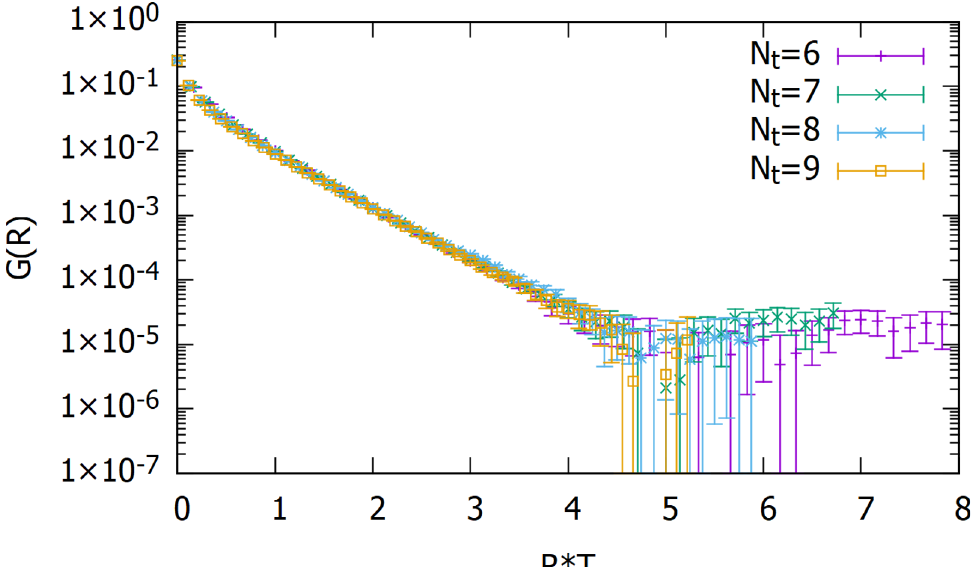
Figure 1 . Collapse of data in the Polyakov-loop two-point correlation function G ( R ) obtained for different values of N , from 6 to 9 , at the same temperature, T = 0 . 62 T t logarithmic scale for the vertical axis, are plotted as a function of the distance between the loops, R , in units of the inverse